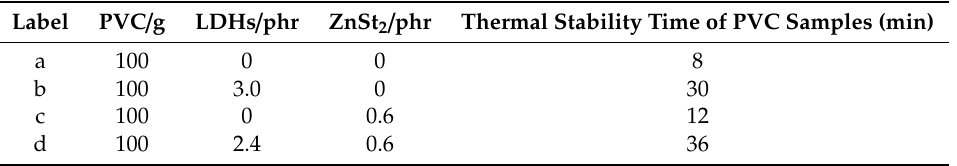
Table 2. The result of Congo red test of PVC samples.